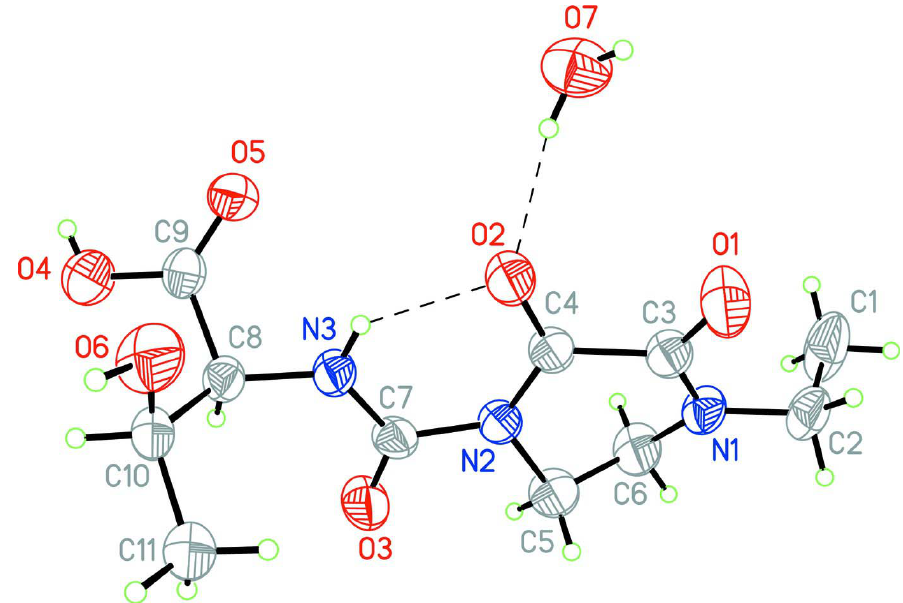
Figure 1 A view of the molecular structure of (I), showing displacement ellipsoids at the 30% probability level. Dashed lines indicate O—H···O and N—H···O hydrogen